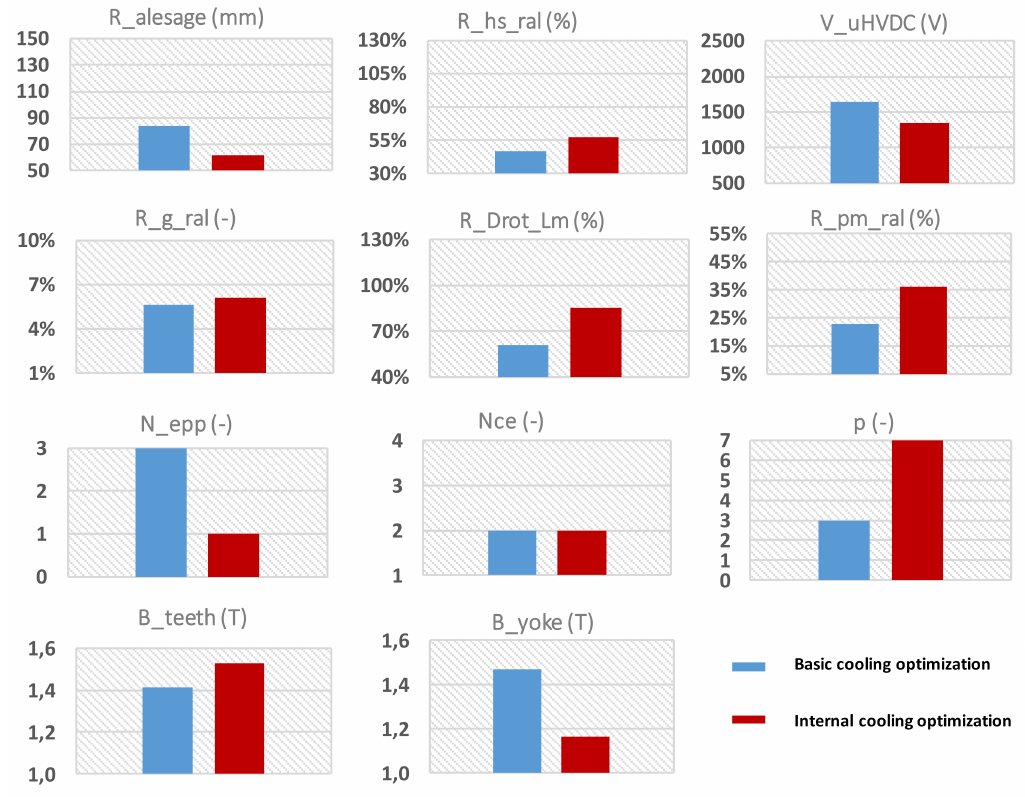
Figure 21. Decision variables of two electric motor optimizations, including cooling